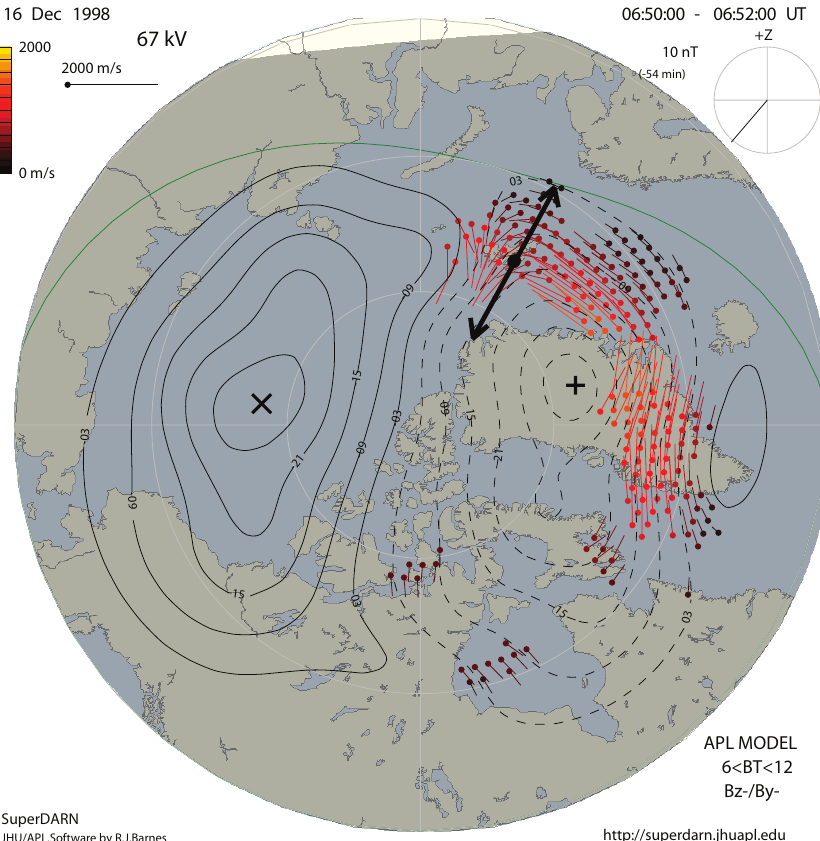
Fig. 8. Plasma convection pattern for 06:50–06:52 UT as obtained from SuperDARN radars. Same format as in Fig.